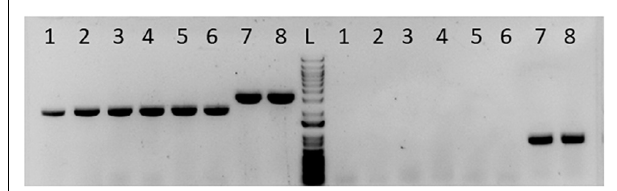
FIGURE 1 | Gel picture showing successful deletion of pta in C. ljungdahlii . Columns labeled 1–6 to the left of the ladder “L” were presumptive pta deletion colonies for single colony purification. Column 7 was wild type DNA mixed with the pta deletion plasmid. Column 8 is the wild type DNA alone. The set of lanes to the left of the ladder “L” was PCR amplifying the pta region. Columns 1–6 show a smaller pta region, indicating loss of pta at that region in the genome. Columns 7 and 8 show the wild type band size. The set of lanes to the right of the ladder (L) was PCR amplifying a region inside pta . Columns 1–6 show no fragment amplified, indicating no detectable pta in those colonies. Columns 7 and 8 show the fragment of pta in unedited